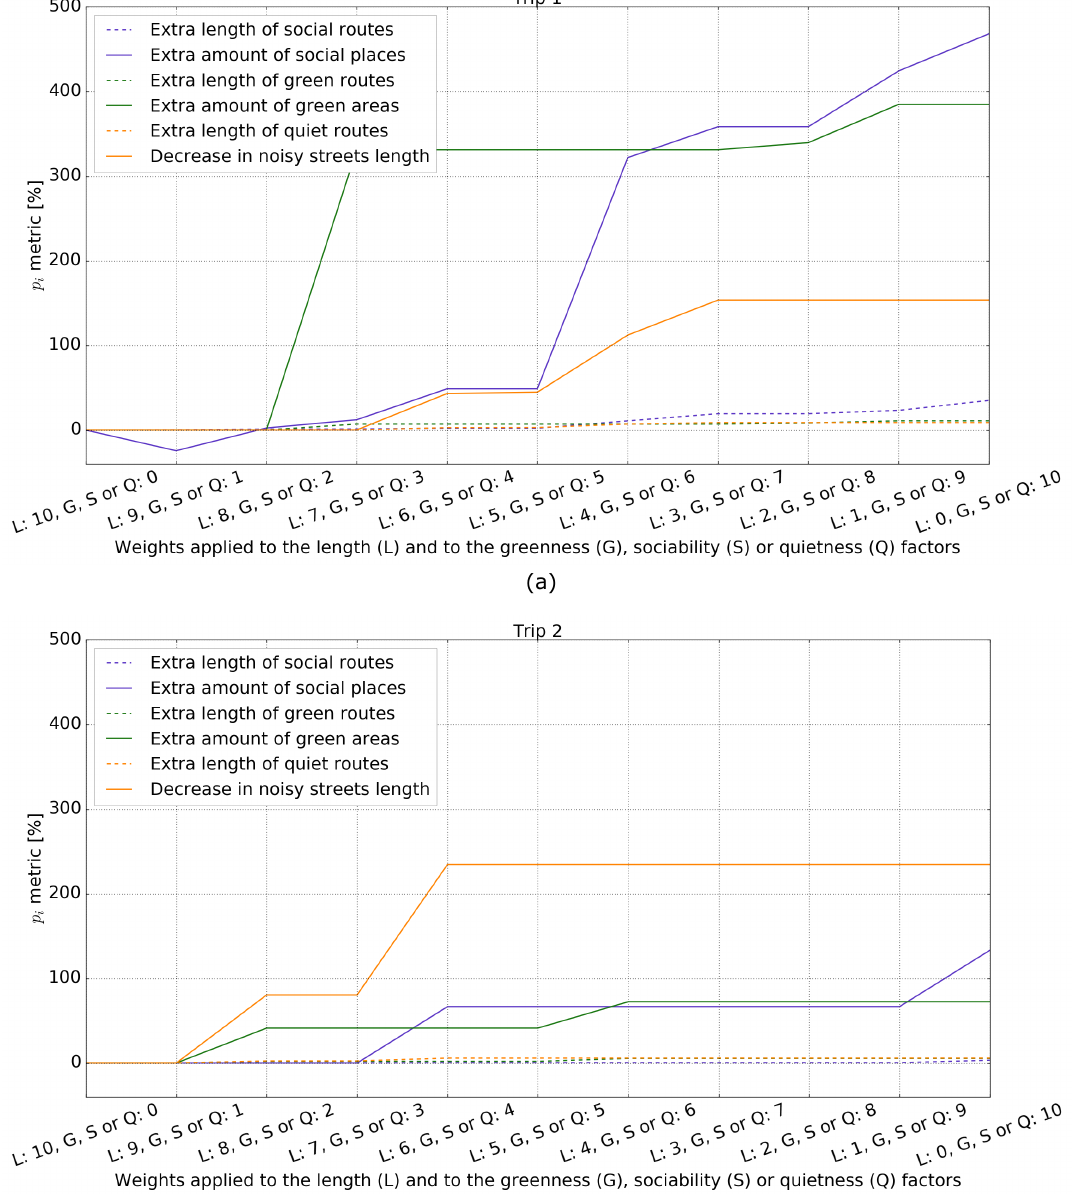
Figure 5. Graph plots of the p i metric computed for two trips, shown in ( a ) and ( b ), and the eleven discrete weight pairs summing to 10, i.e., (10,0),...,(0,10). Each pair of weights were applied to the length (L) and to the greenness (G), sociability (S), or quietness (Q) factor